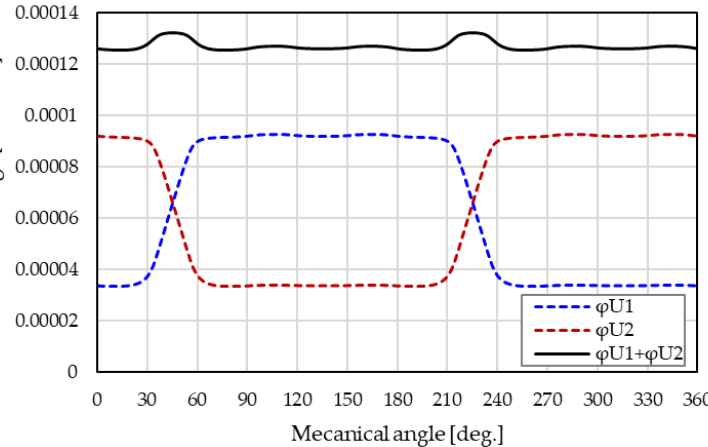
Figure 15. Analytical armature flux linkage waveform ( Φ U , Φ U 1 , and Φ U 2 ) at 1 A (DC) and FFT